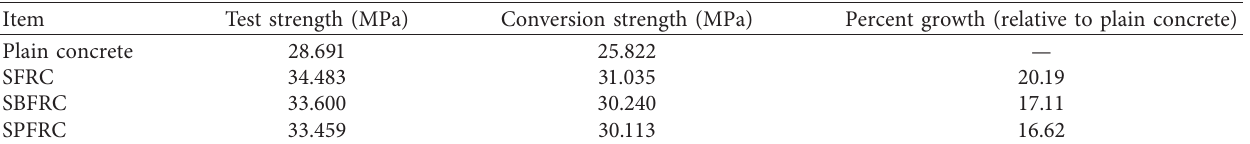
Figure 1: Test process. (a) Compressive strength test; (b) flexural strength test. Table 2: Results of compressive test.